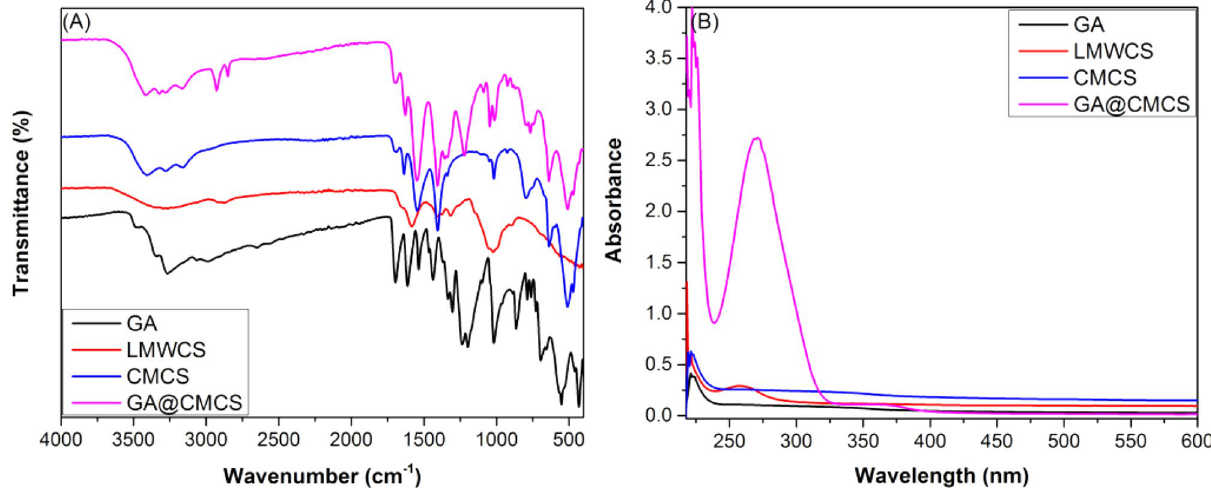
Figure 2. ( A ) Collective FTIR spectra of GA, LMWCS, CMCS, and the conjugate (GA@CMCS) for comparison of their respective characteristic vibration bands. ( B ) UV–Vis spectra of the GA, LMWCS, CMCS, and (GA@ CMCS) in aqueous acetic acid (0.5%, v/v) (0.5